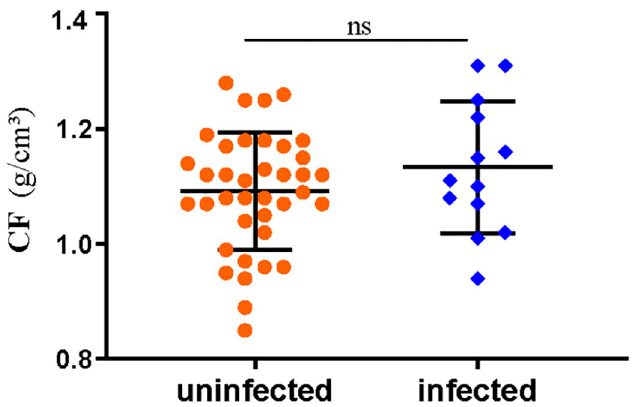
Fig 10. The condition factor of grass carp (uninfected group, without S . acheilognathi infection; infected group: Infection with S . acheilognathi ; ns, no significance).